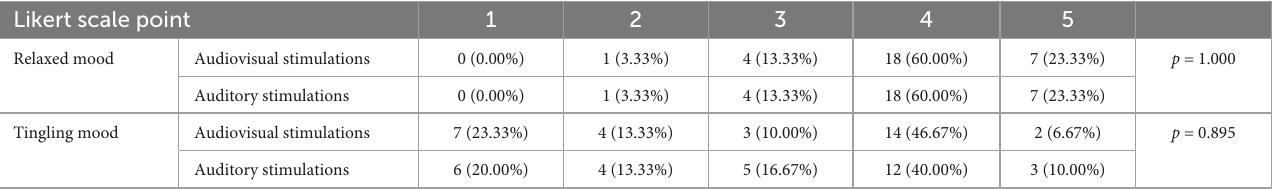
TABLE 1 Questionnaire results for the two moods (“relaxed mood” and “tingling mood”). Likert scale